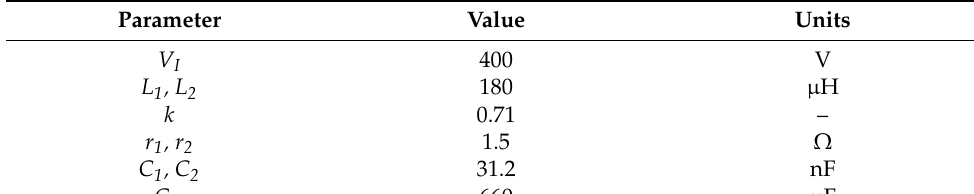
Table 1. System Parameter Values.